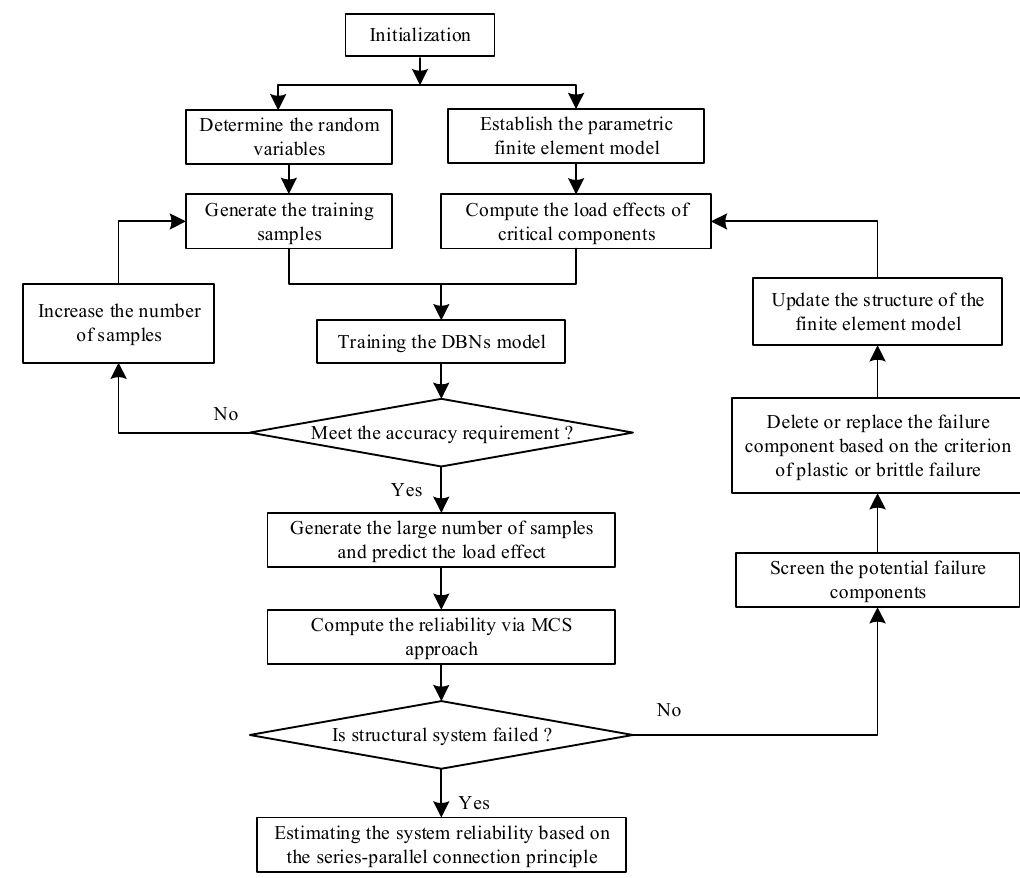
Figure 5. Flowchart of evaluating system reliability of a cable-stayed bridge via DBNs.